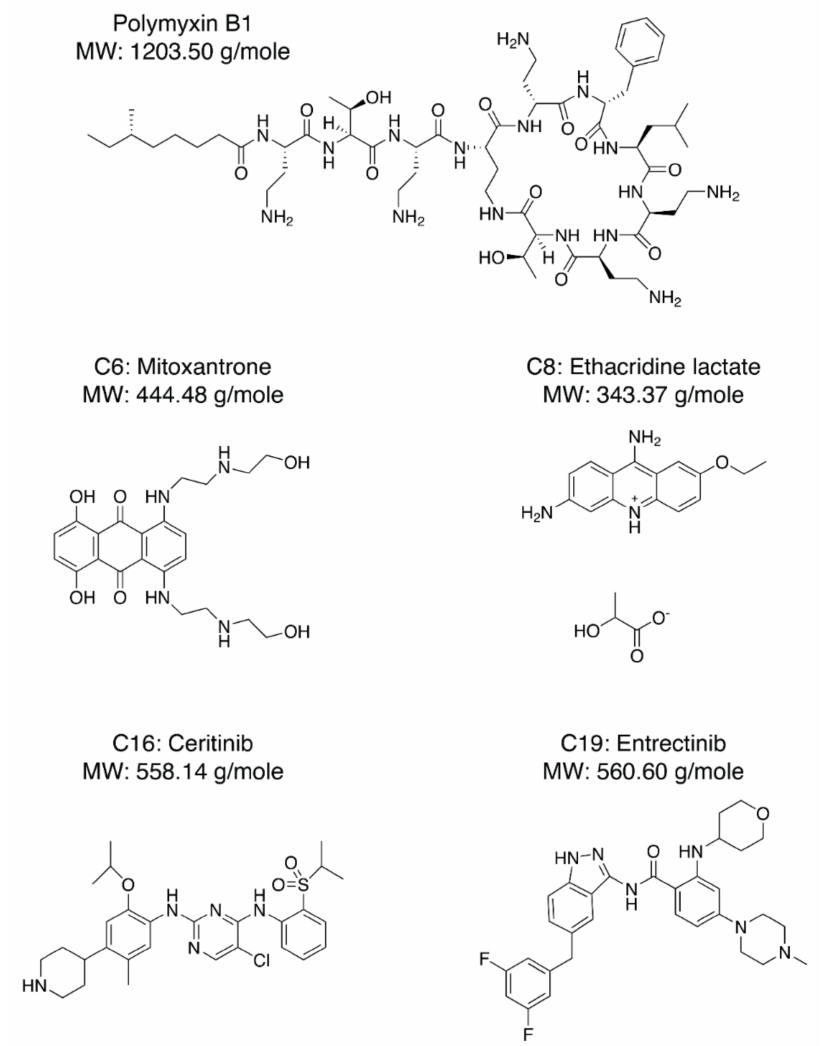
Figure 5. Chemical structures of PMB (Polymyxin B1), C-6 (Mitoxantrone), C-8 (Ethacridine lactate), C-16 (Ceritinib), and C-19